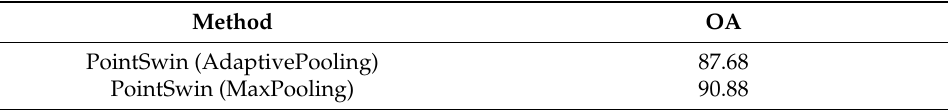
Table 8. Results of ablation experiment about MaxPooling function.